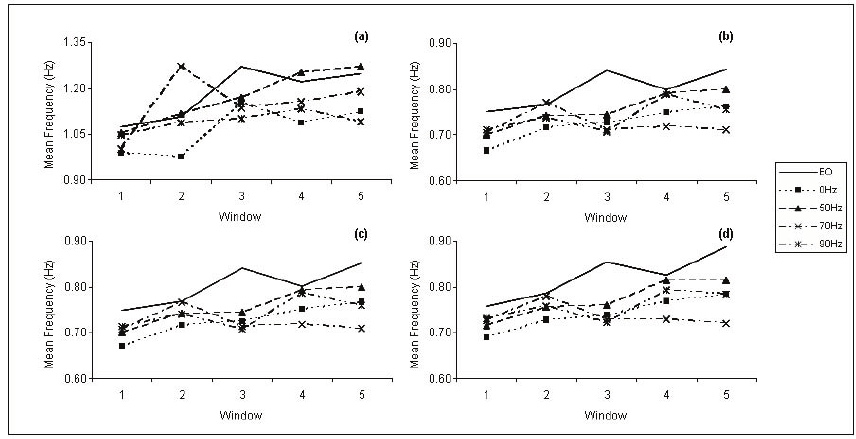
Figure 4. The effect of time on mean frequency estimation using Fourier–Bessel Expan- sion for 200-point windows (AP): (a) No window; (b) Hamming window, (c) Gaussian window ( (cid:5) D 2:5 ), (d) Kaiser window ( ˇ D 8